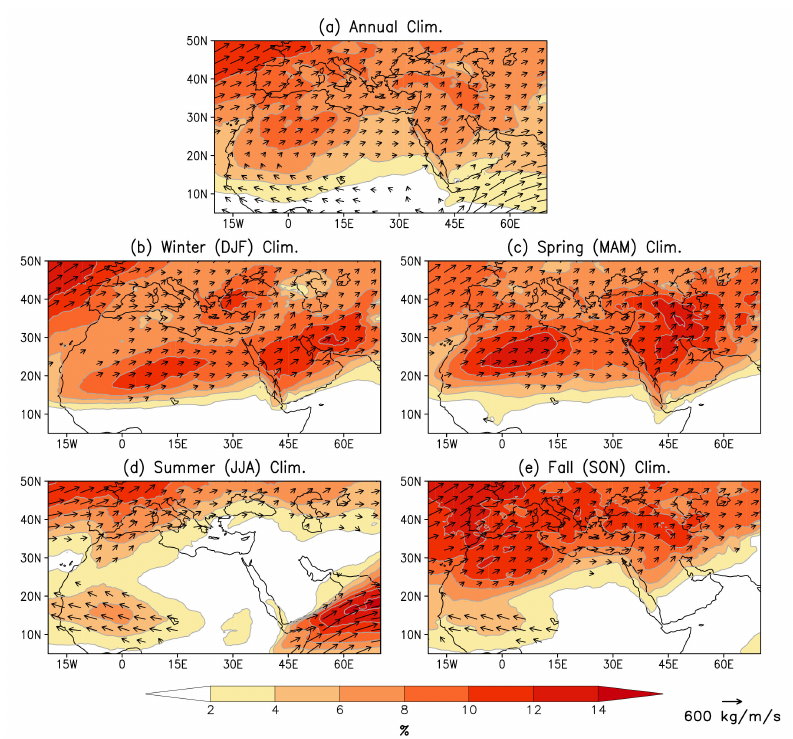
Figure4. ARfrequency(%oftimesteps)andIVT(kg / m / s)plotsfortheMENAregion, shown( a )annually and ( b – e ) for each season. Figures show the AR occurrence frequency at 6-hourly time steps over the analysis period of